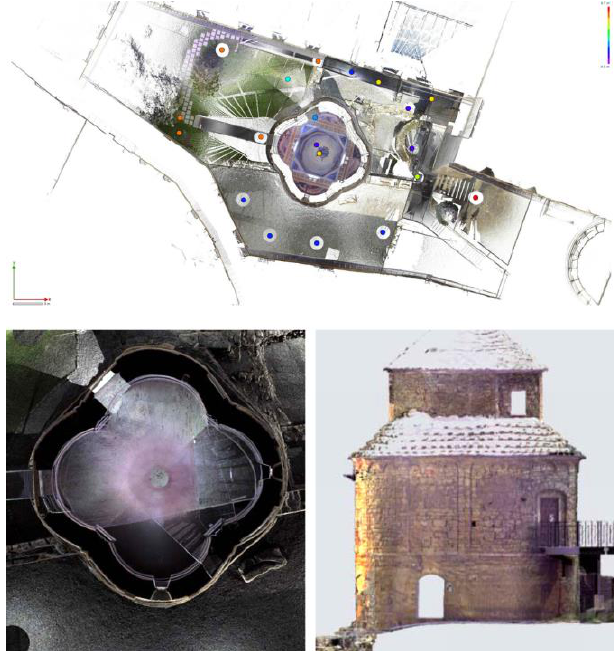
Fig. 4 The Laser Scanner survey and one of orthophotos